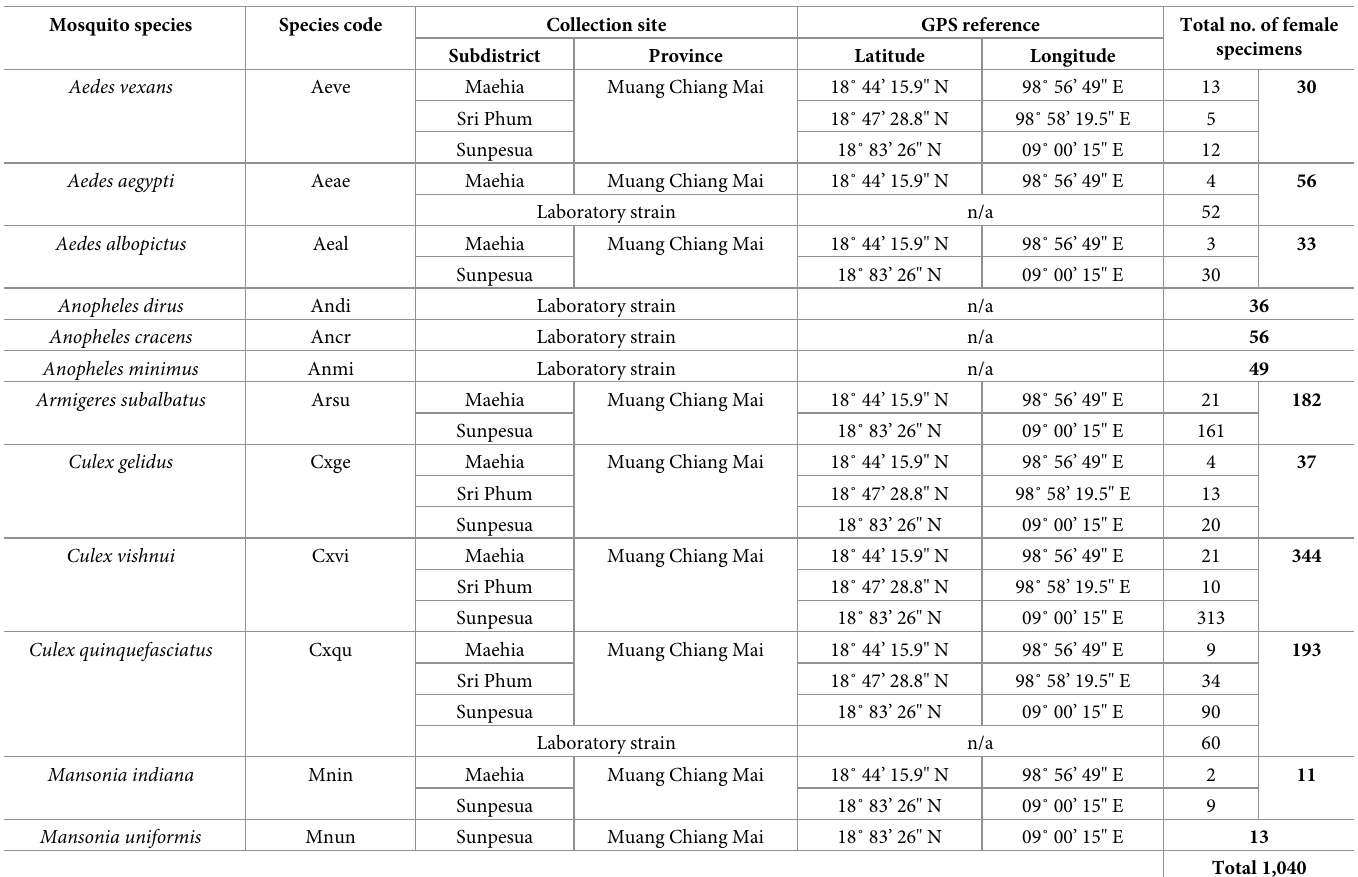
Table 1. Mosquito specimens used in this